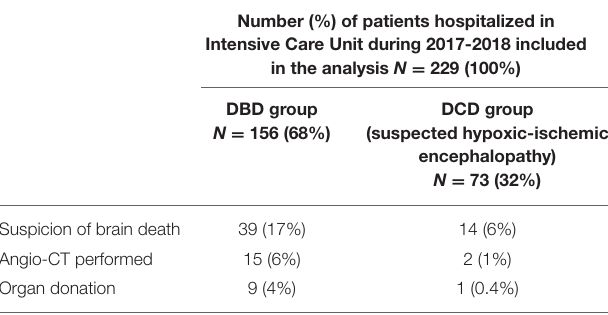
TABLE 2 | The number of patients in two subgroups in relation to suspicion of brain death, angio CT performed and actual organ donation. Number (%) of patients hospitalized in Intensive Care Unit during 2017-2018 included in the analysis N = 229